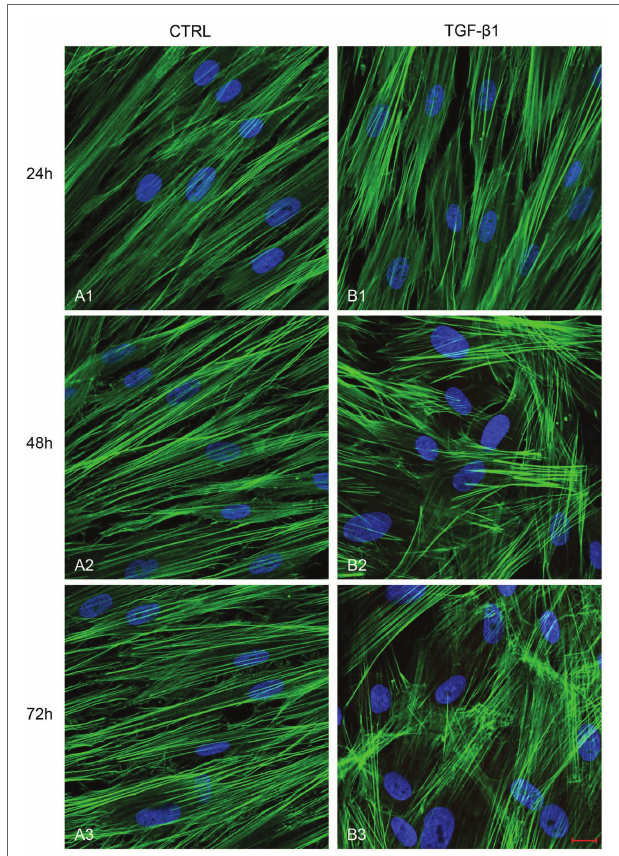
FIGURE 2 | Images observed at Confocal Laser Scanning Microscopy (CLSM) of untreated hGFs (A1-A3) compared to hGFs treated with TGF- β 1 (10 ng/ml) at 24, 48, and 72 h (B1-B3) . Cytoskeleton actin was stained with green fluorescence; nuclei were stained with blue fluorescence. Scale bar: 20 μ m; magnification